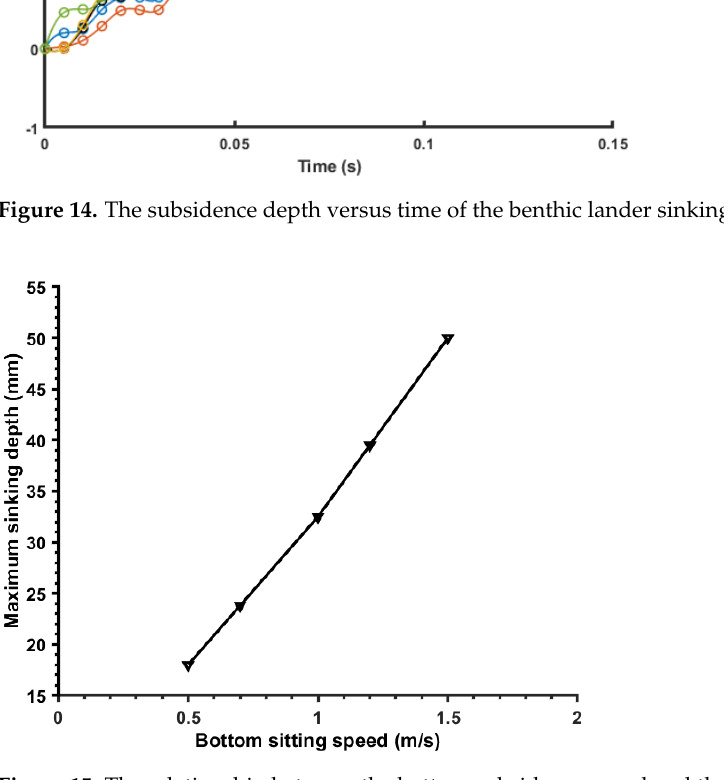
Figure 15. The relationship between the bottom subsidence speed and the depth of depression.